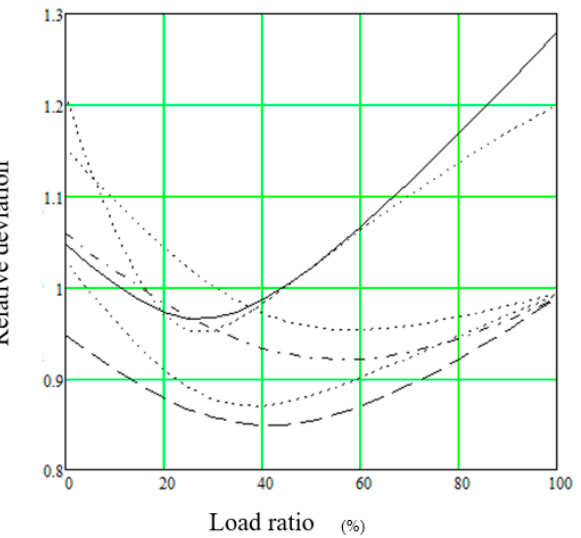
Figure 7. Relative deviation of the calculated material factors and reliability indexes regarding the recommended values. Solid line, steel, γ M = 1.0; dashed line, γ M = 1.3, timber; and dash-dotted line concrete, γ M = 1.4. The dotted lines display the corresponding deviations of the reliability indexes.